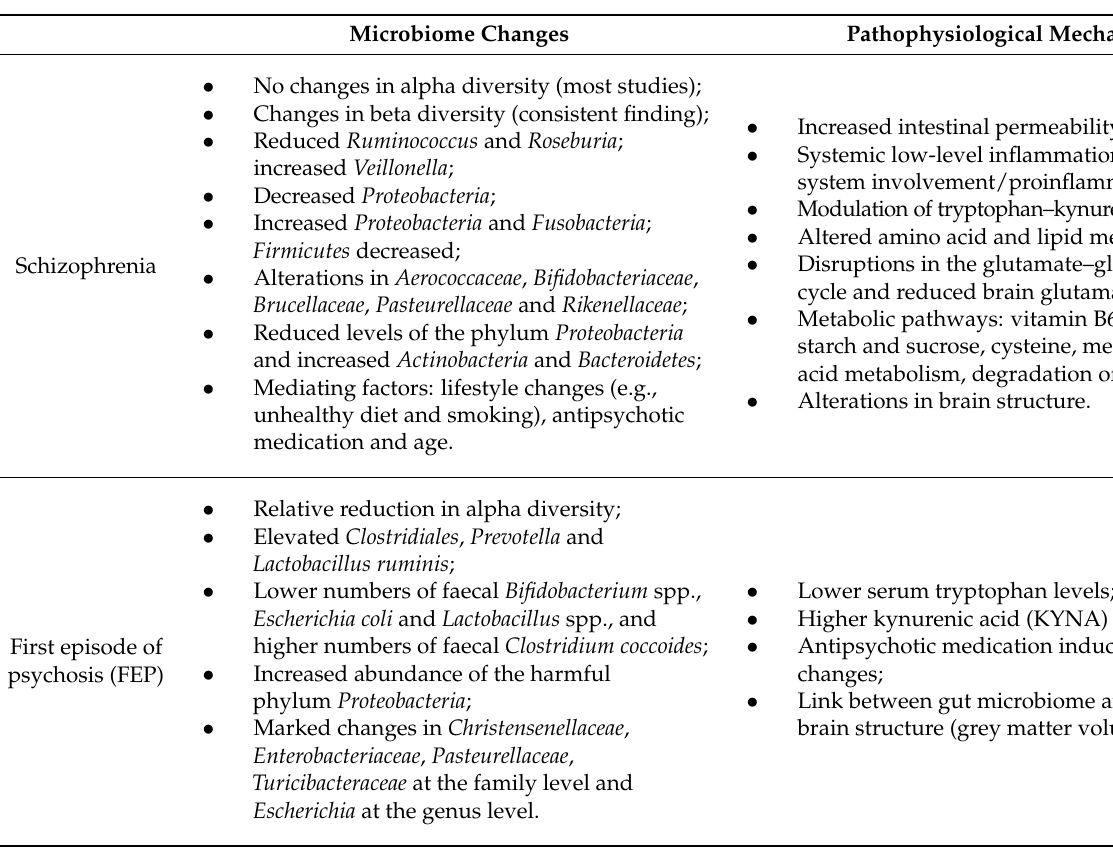
Table 1. Gut microbiome and schizophrenia/first episode of psychosis: changes in microbiome composition and possible pathophysiological